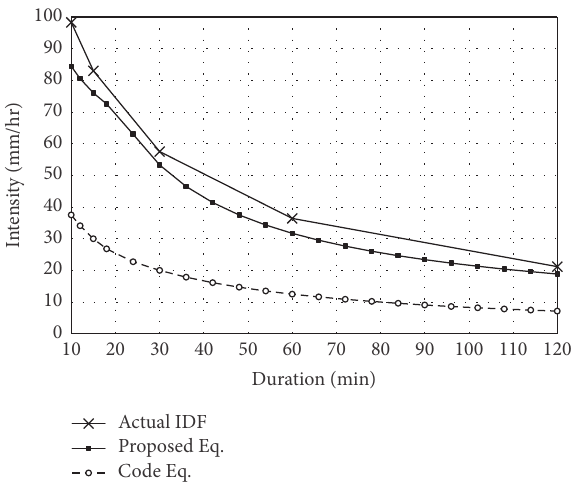
Figure 6: Comparison of rainfall intensity curve 𝐼 (mm/hr) for Alexandria.